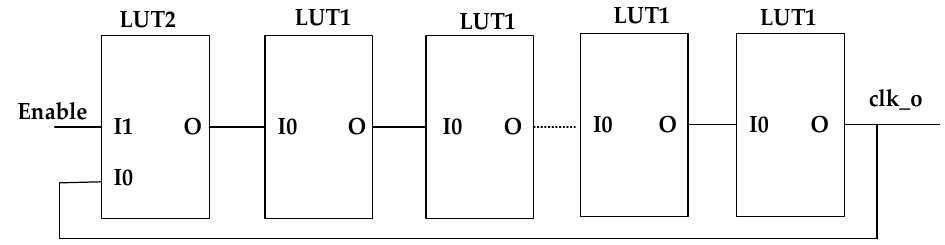
Figure 6. Block diagram of the inverter-based ring oscillator.